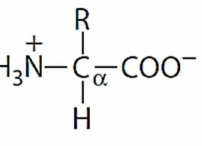
Figure 2. The zwitterionic (ionized) form of an amino acid